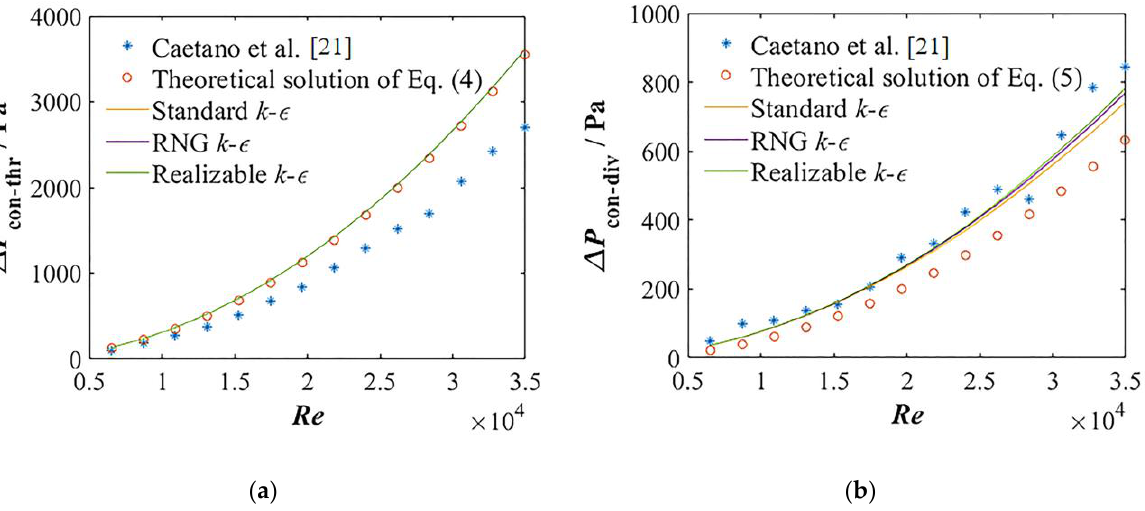
Figure 6. Pressure drops ( a ) ∆ P con-thr and ( b ) ∆ P con-div as a function of the Reynolds number [21].